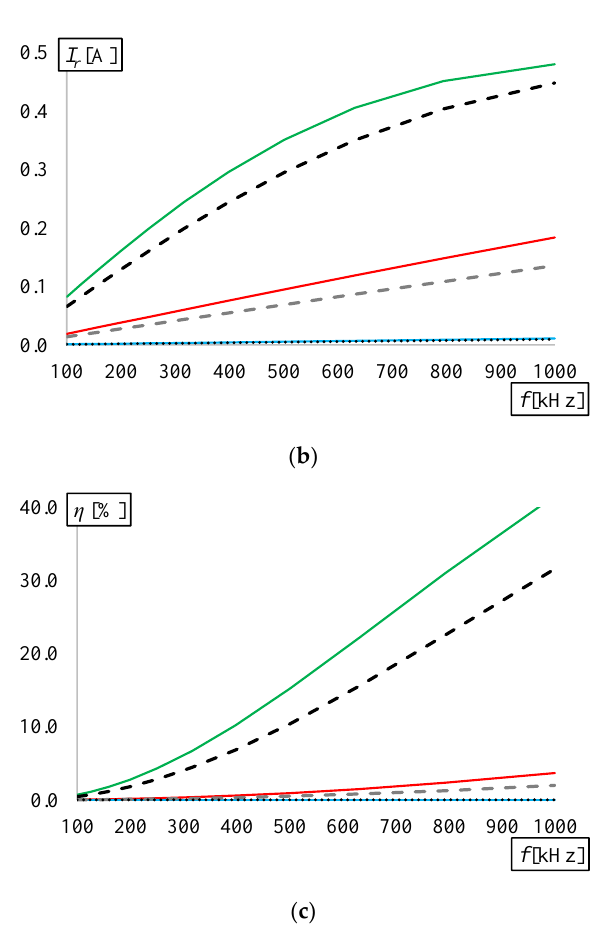
Figure 9. Results for the case r c = 5 mm, n c = 30: ( a ) transmitter current, ( b ) receiver current, and ( c ) power transfer efficiency.